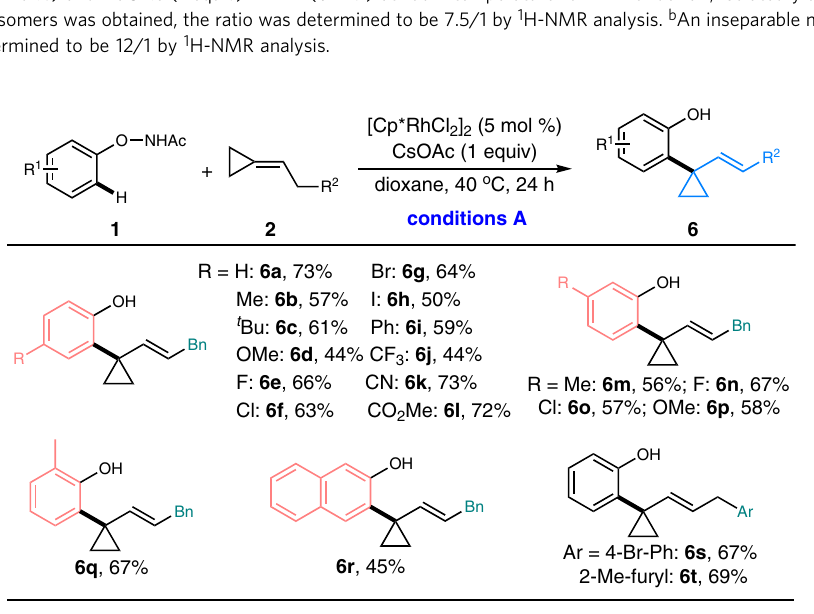
Fig. 5 Substrate scope for C – H cyclopropylation. Reaction conditions A: 1 (0.2 mmol), 2 (0.4 mmol), [Cp*RhCl 2 ] 2 (5 mol%), and CsOAc (1 equiv) in dioxane (0.2 M) at 40 °C for 24 h under air, isolated yields were